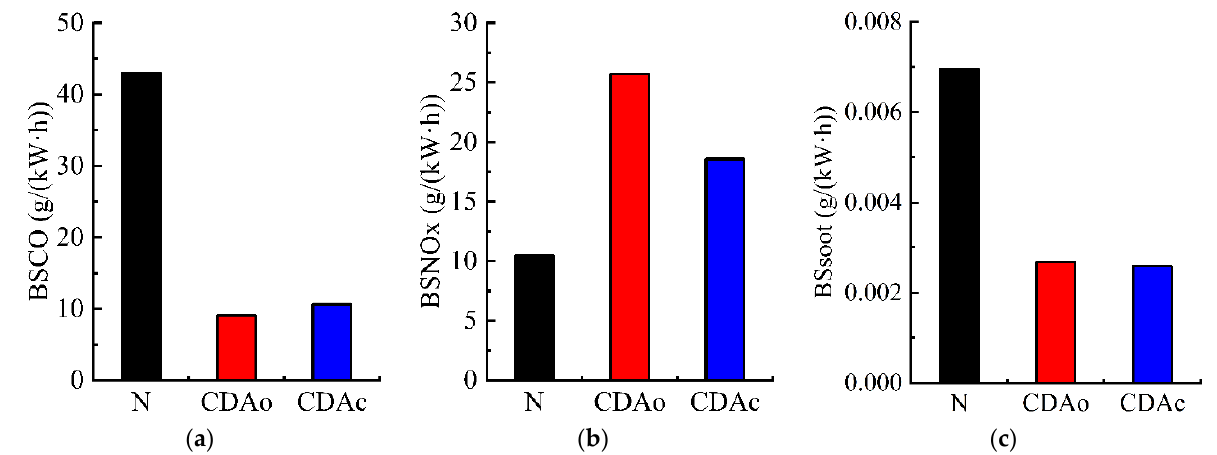
Figure 12. The brake-specific carbon monoxide (BSCO) ( a ), the brake-specific nitrogen oxides (BSNOx) ( b ), and the brake-specific soot emission (BSsoot) ( c ) for the normal operation and two CDA modes at an engine speed of 450 rpm and an engine load of 1000 N ∙ m (the emission results were transformed from 3D simulation of ESE DIESEL).